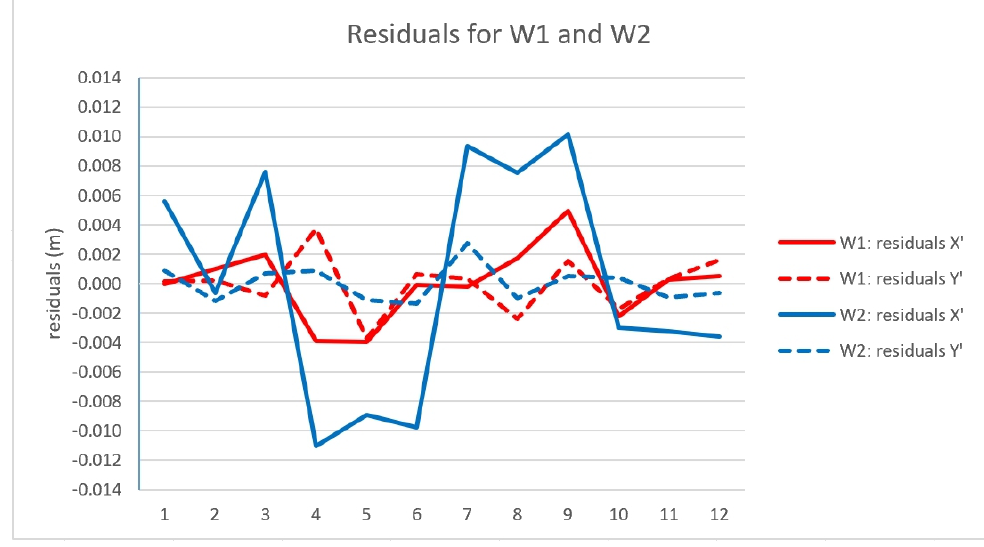
Figure 9. Residuals in meters for the different targets on the walls.